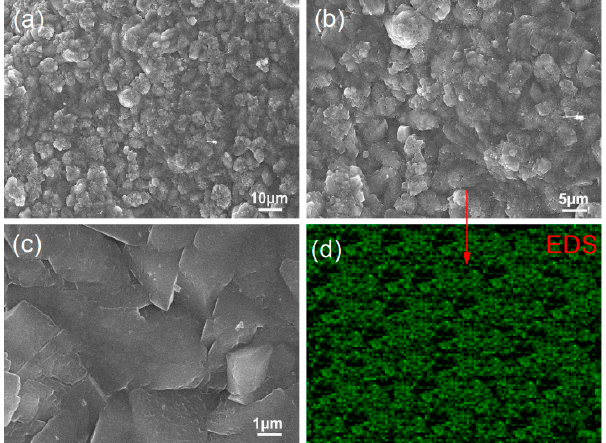
Figure 10. ( a – c ) SEM images of GO/PAA/cement composites with GO/PAA intercalation composites. ( d ) Carbon map of the area presented in ( b ). ( d ) Carbon map of the area presented in ( b